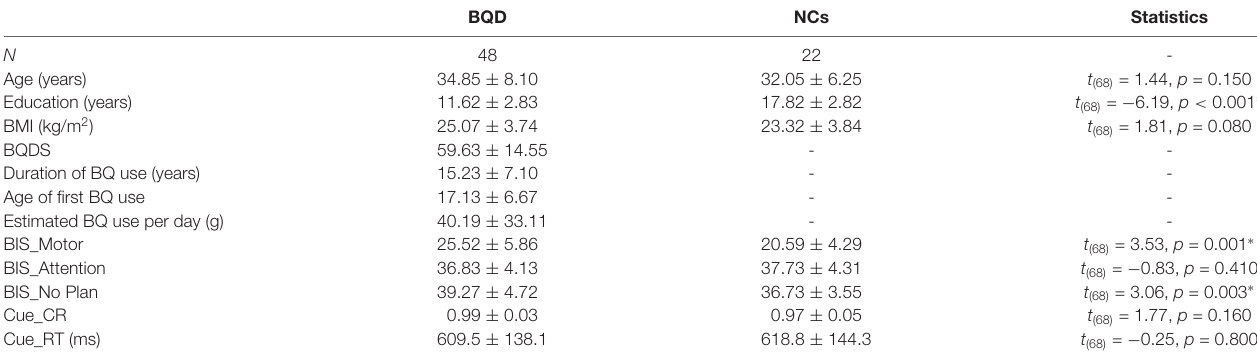
TABLE 1 | Demographic and impulsivity characteristics of participants (M ± SD).